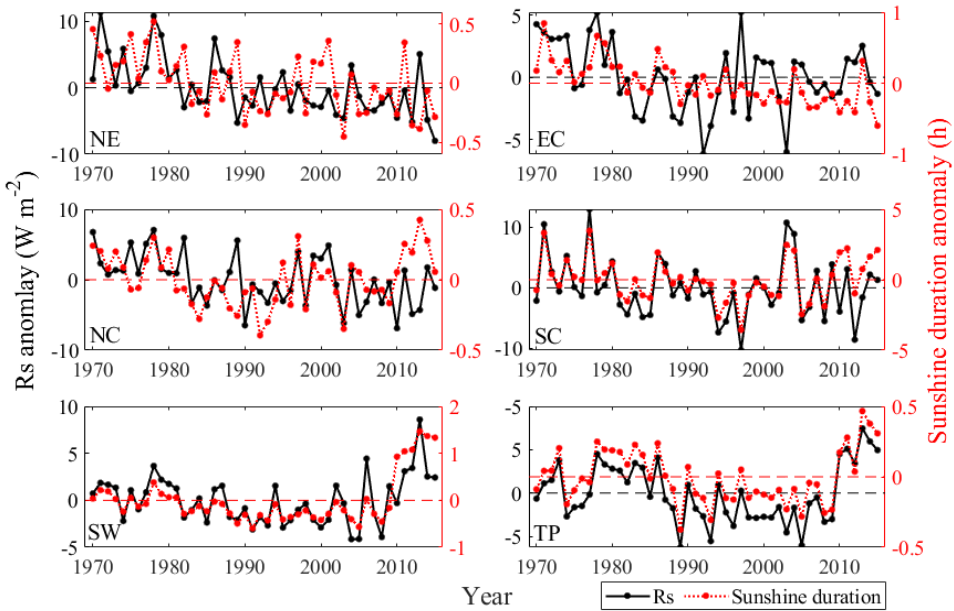
Figure 15. Comparison of the anomaly of the annual mean Rs and sunshine duration between 1970 and 2015 in six climatic regions.